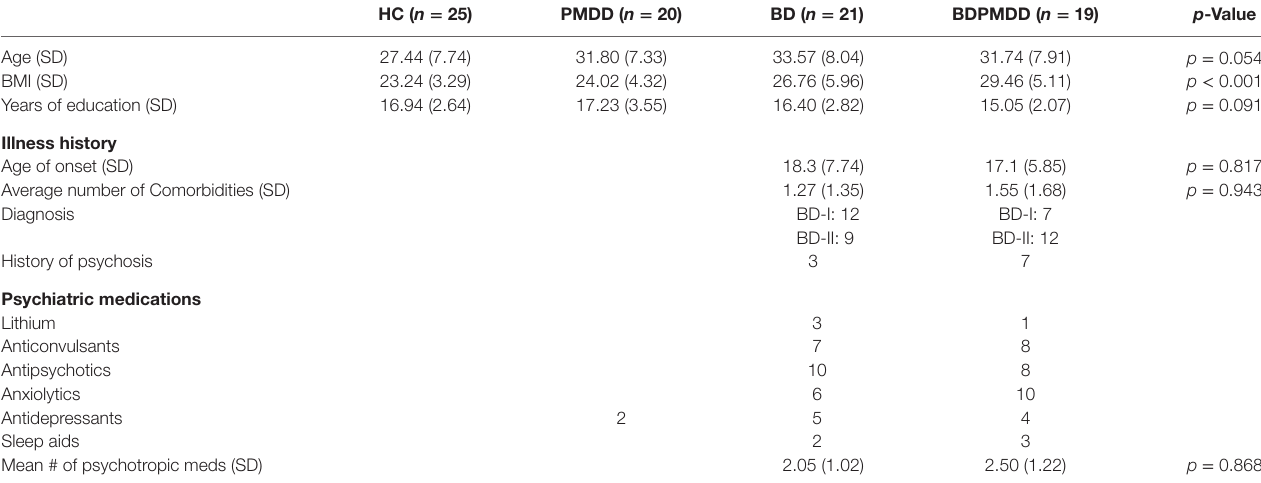
TaBle 1 | Participants